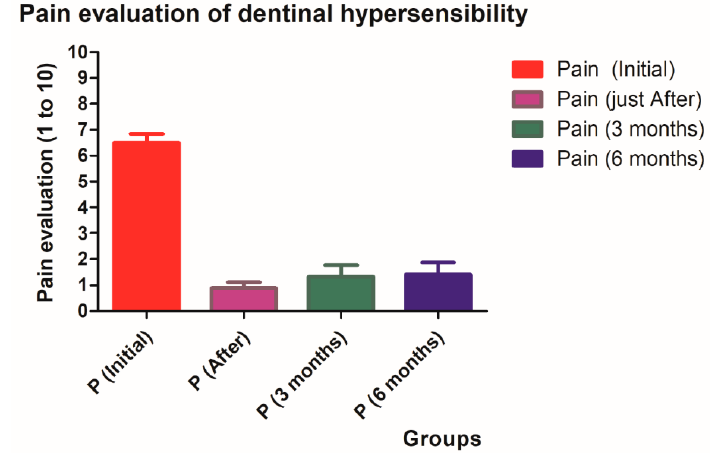
Figure 1. Results of the pain evaluation of dentinal hypersensitivity of different groups with the visual analog scale.